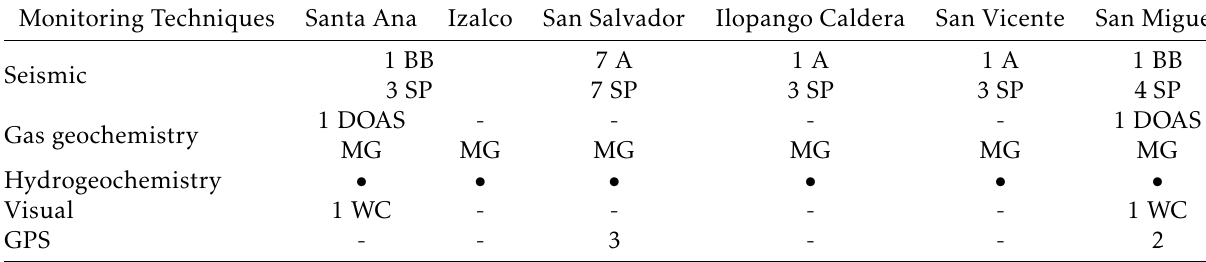
Table 2: Stations/equipment per techniques at monitored active volcanoes of El Salvador. A = accelerograph; BB = broadband; DOAS = differential optical absorption spectroscopy; MG = multiGas; SP = short period; WC = webcam. Seismic stations, DOAS, WC, and GPS are permanent, hydrogeochemical measurements are performed during field campaigns ( ‚